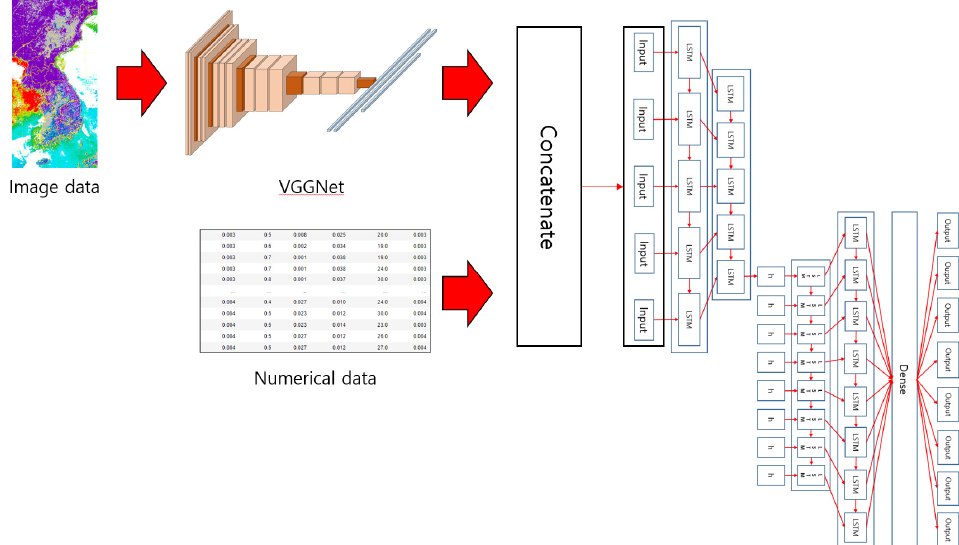
Figure 8. Multimodal deep learning model: First, a feature map of image data is extracted through CNN/VGGNet. Then, the feature map and numerical data are reconstructed to have time series characteristics and merged through concatenate layer. Finally, the merged data is processed by the LSTM AutoEncoder.